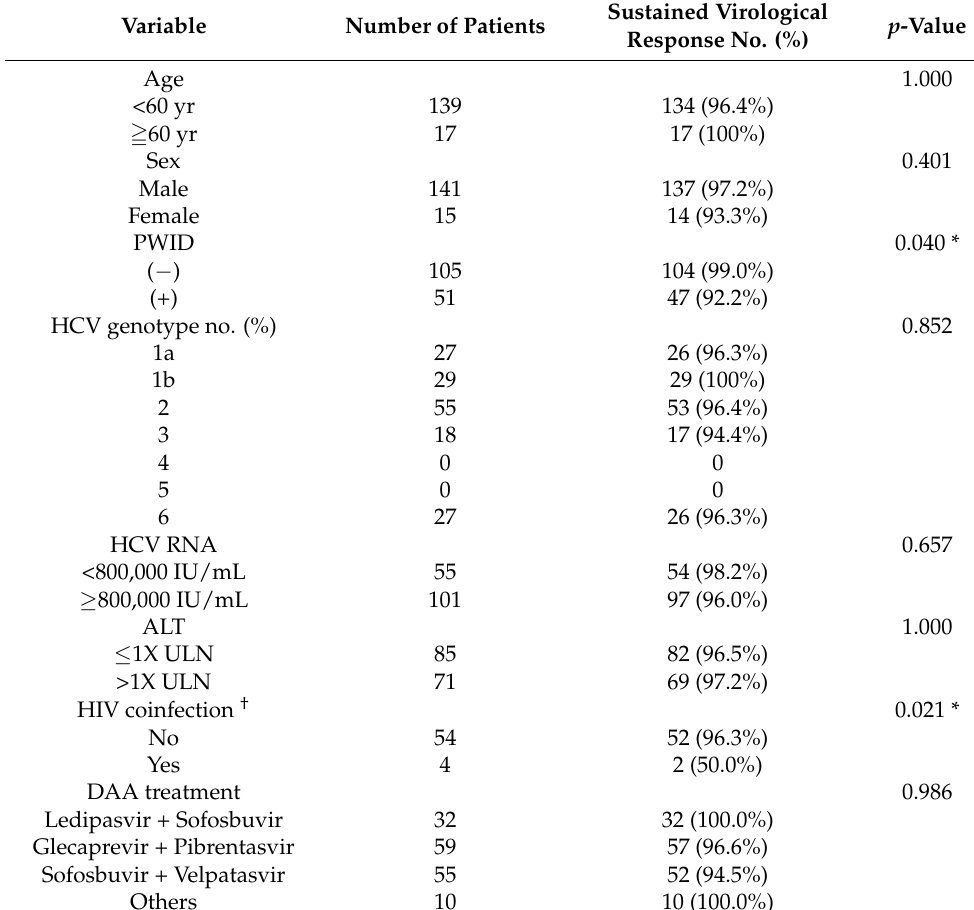
Table 4. Clinical and virological factors related to sustained virological